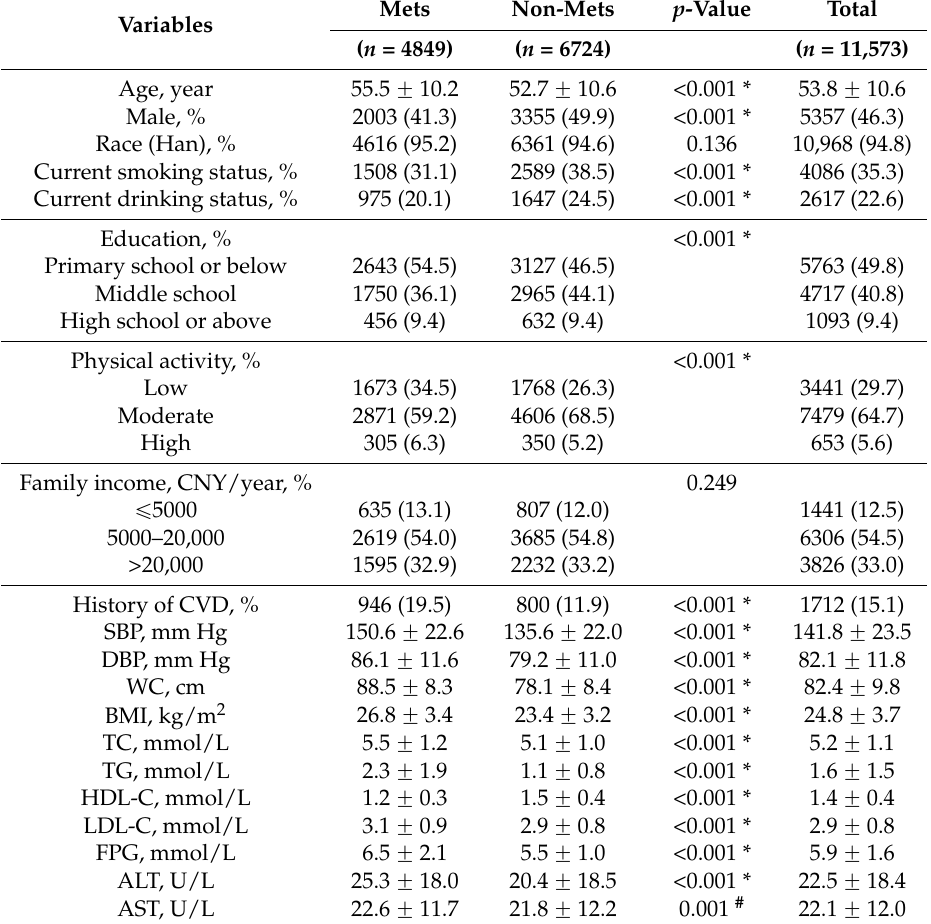
Table 1. Baseline characteristics in subjects with and without metabolic syndrome ( n =